Question: What kind of plot is shown here?
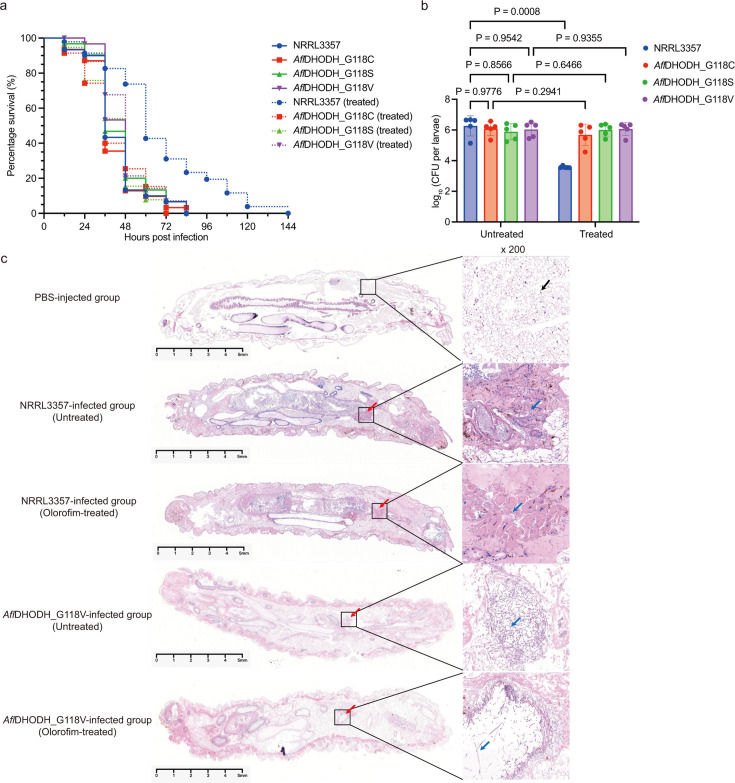
Answer: survival